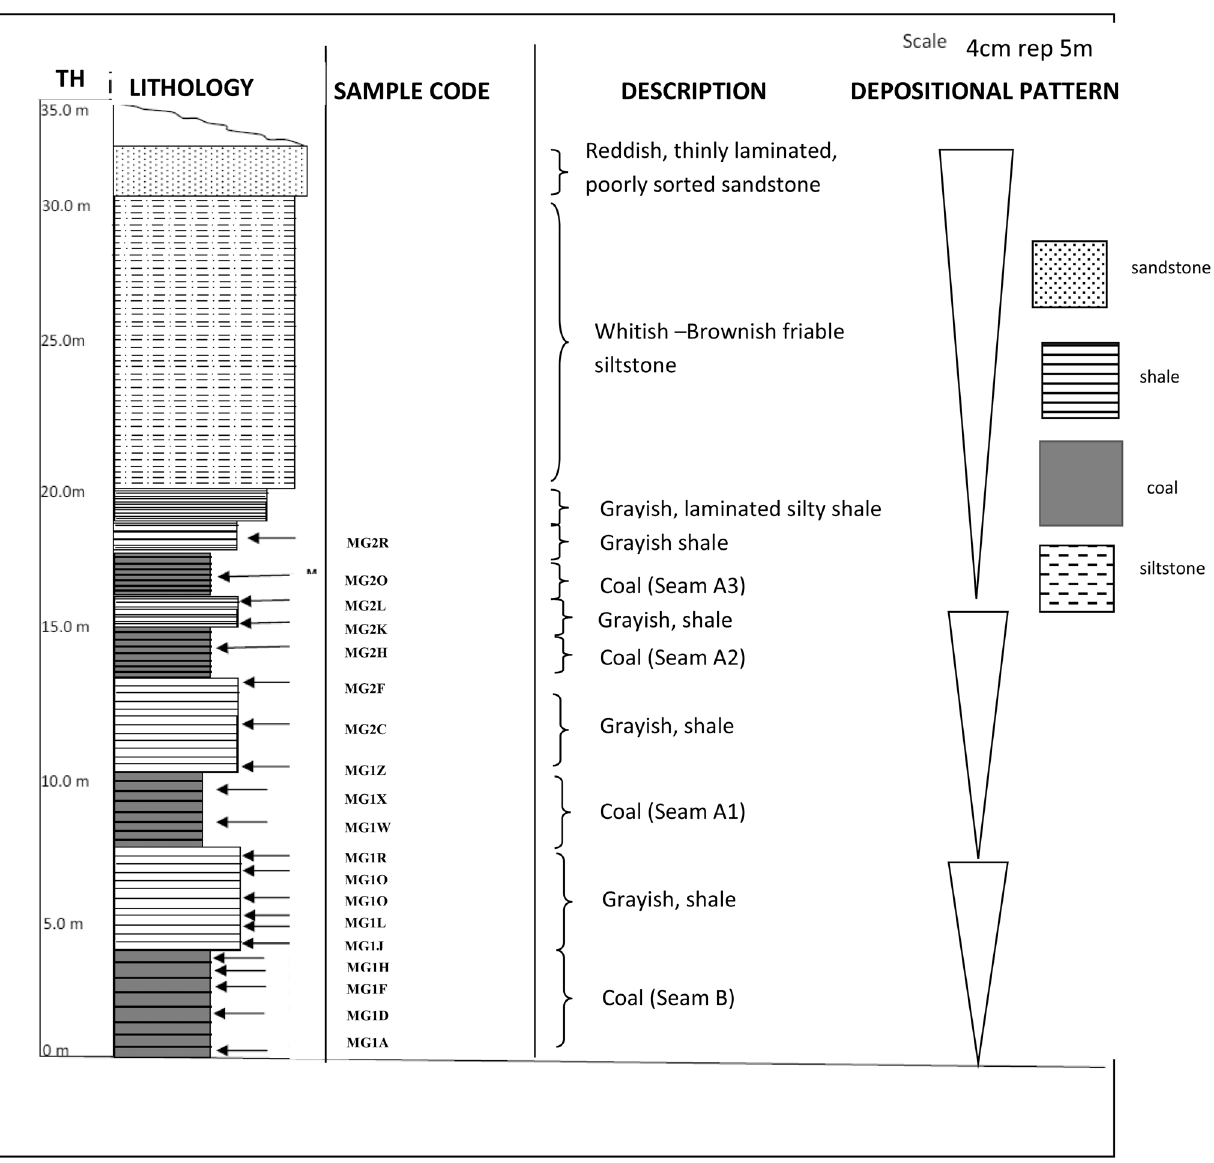
Fig. 4 Lithologic succession of Gombe Formation at the Maiganga mine (Phase I). The succession coarsens upward from coal, shale, siltstone to sandstone. The arrows indicate the selected and analysed samples. Note the coordinates: 10°02 ′ 39 ″ N, 11°12 ′ 17 ″